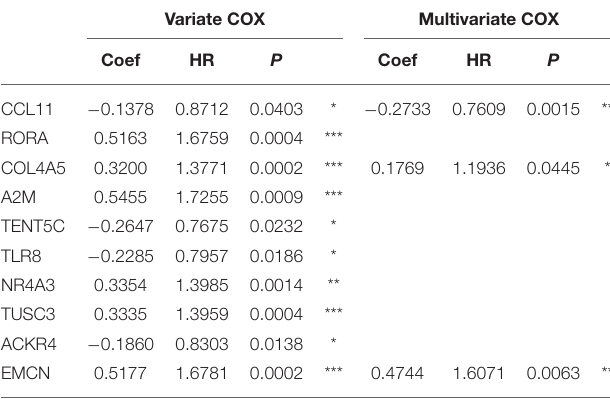
TABLE 1 | The univariate and multivariate Cox regression analysis between 10 robust markers and OS in diffuse type GC. Variate COX Multivariate